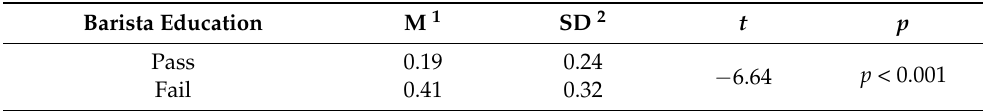
Table 3. Results of unpaired T-test for hypothesis 3 for barista education.